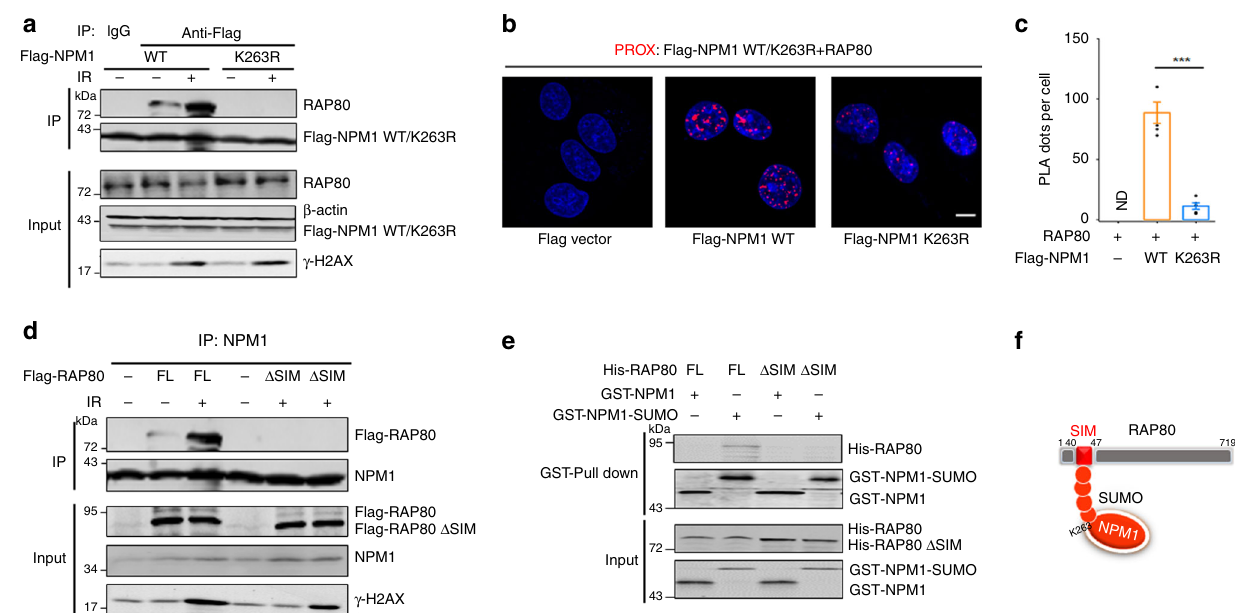
Fig. 6 SUMOylated NPM1 directly binds to the RAP80 SUMO-interacting motif (SIM) domain. a HEK293T cells transfected with Flag-NPM1 WT or K263R mutant vectors were treated with or without IR, and then subjected to co-IP analysis using anti-RAP80 and anti-Flag antibodies. b U2OS cells transfected with Flag-NPM1 WT or K263R were grown on collagen-coated microchamber slides. After fi xation, in situ PLA for NPM1 WT or K263R and RAP80 was performed with anti-Flag and anti-RAP80 antibodies. The PLA-detected proximity (PROX) complexes are represented by the fl uorescent rolling circle products (red dots). Scale bar, 10 μ m. c Quanti fi cation of the PROX dots per cell is shown as mean ± SEM with the P value indicated. *** P < 0.001. d HEK293T cells transfected with Flag-RAP80 FL or Δ SIM mutant vectors were treated with or without IR, and then subjected to co-IP analysis using anti- NPM1 and anti-Flag antibodies. e In vitro interaction of puri fi ed RAP80 with NPM1-SUMO2/3. The full-length and SIM domain (40 – 47 aa) deleted truncation of His-RAP80 and GST-NPM1 were puri fi ed from E. coli . GST-NPM1 protein was SUMOylated in vitro, and the pull-down analysis was performed. f Schematic of the direct interaction between SUMOylated NPM1 and RAP80 SUMO-interacting motif (SIM). Unprocessed scans of blots are provided in Supplementary Fig.